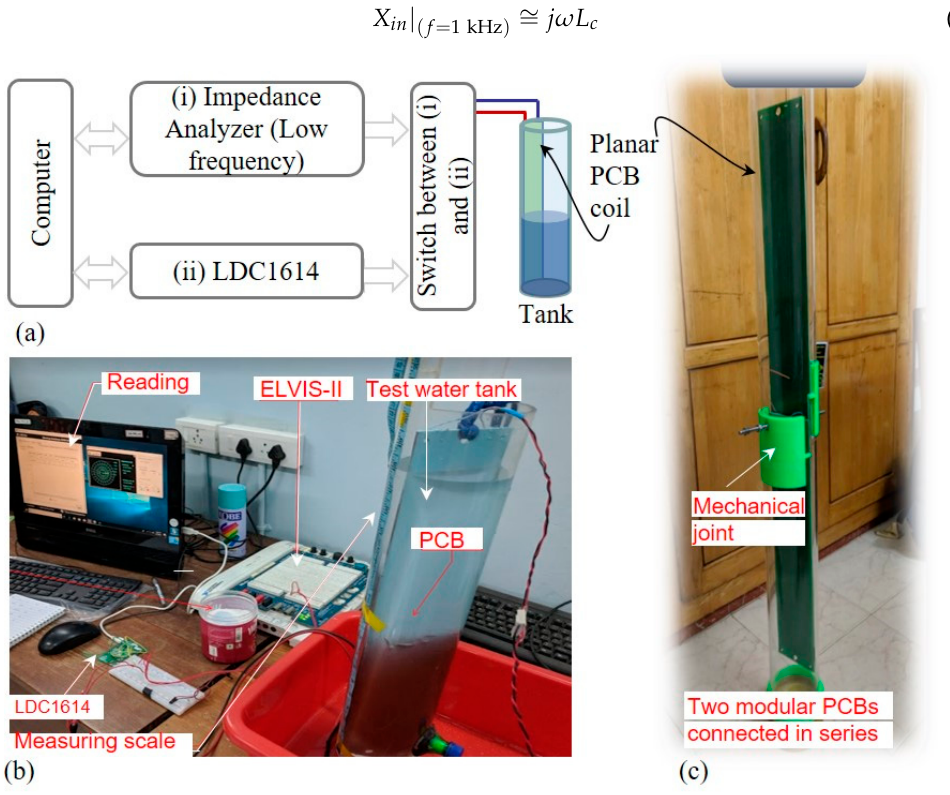
Figure 3. Experimental setup: ( a ) block diagram of the setup; ( b ) laboratory setup for testing; ( c ) prototype planar coils, connected electrically and mechanically in series to extend the range.